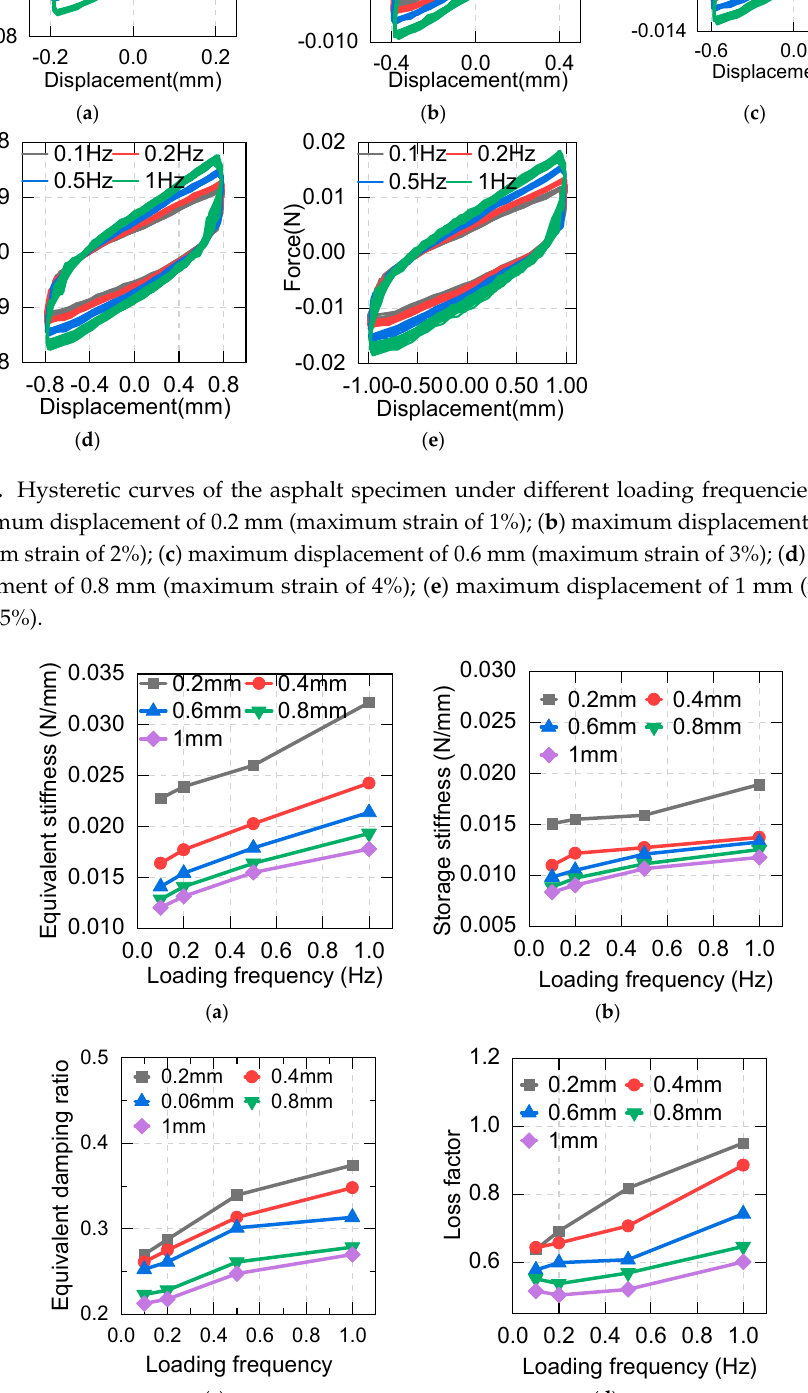
( d ) Figure 6. Hysteretic curves of the asphalt specimen under different loading displacements at 20 °C: ( a ) loading frequency of 0.1 Hz; ( b ) loading frequency of 0.2 Hz; ( c ) loading frequency of 0.5 Hz; ( d ) loading frequency of 1 Hz. The effect of loading displacement on damping properties is shown in Figure 7. The results show that all the parameters decrease with the increasing loading displacement. This means that isolation buildings possess larger stiffness and damping ratios at low vibration levels.